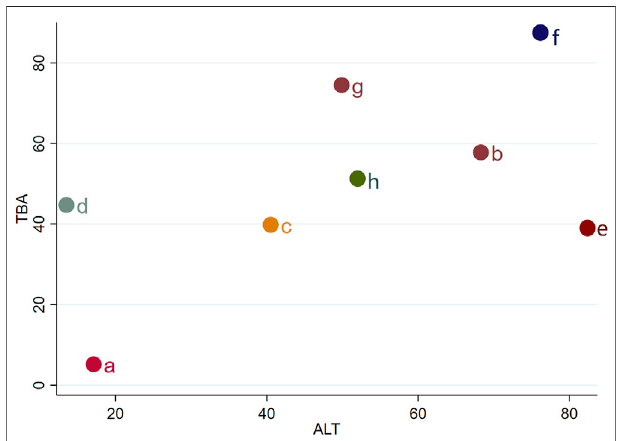
FIGURE 6 | Sequence analysis of comprehensive ef fi cacy. From the top right to bottom left, the comprehensive effect gradually decreases. Notes: a: UDCA, b: Yinzhihuang oral liquid + UDCA, c: salvia injection + UDCA, d: Yinchenhaodecoction+UDCA,e:thesimilarprescriptionofYinchenhao decoction 1 + UDCA, f: the similar prescription of Yinchenhao decoction 2 + UDCA, g: the similar prescription of Yinchenhao decoction 3 + UDCA, and h: